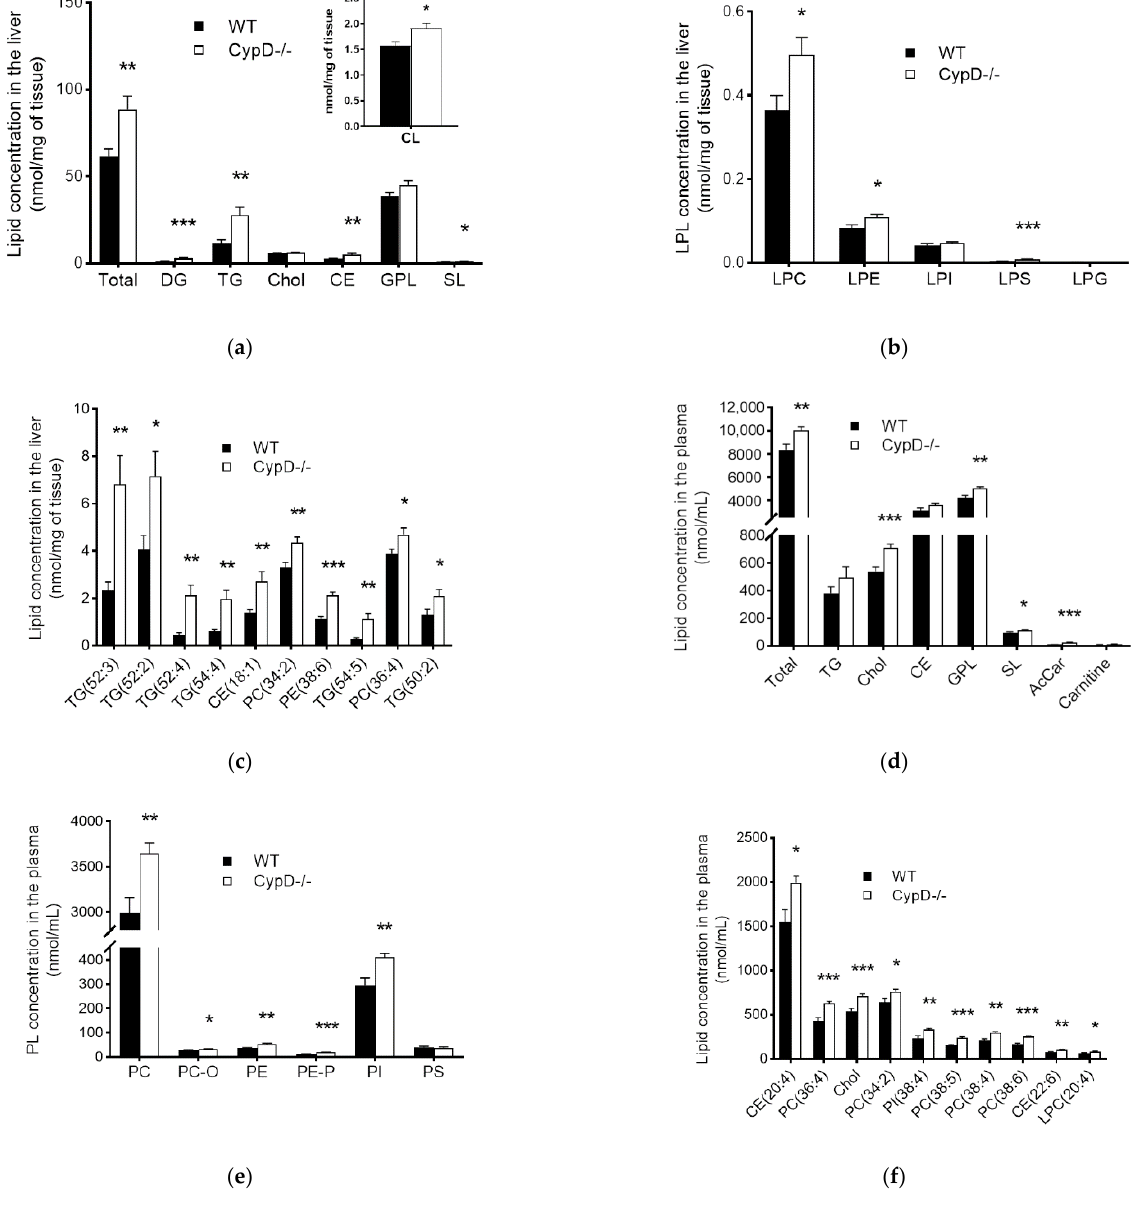
Figure 2. Comparison of the absolute lipid content of WT and CypD-/- samples. Bar charts repre- sent the ( a ) total and the lipid class-based lipid content of liver samples with the measured total cardiolipin in insert, ( b ) LPL lipid content, and ( c ) the concentration of the top ten species that contributed most to the overall lipid accumulation in liver samples, as well as the ( d ) total and lipid class-based lipid content of plasma samples, ( e ) PL lipid content and ( f ) the concentration of the top ten species that contributed most to the overall lipid accumulation in plasma samples. Data are shown as mean ± SEM, n = 9–11, * p < 0.05, ** p < 0.01, *** p < 0.001. AcCar: acylcarnitine,